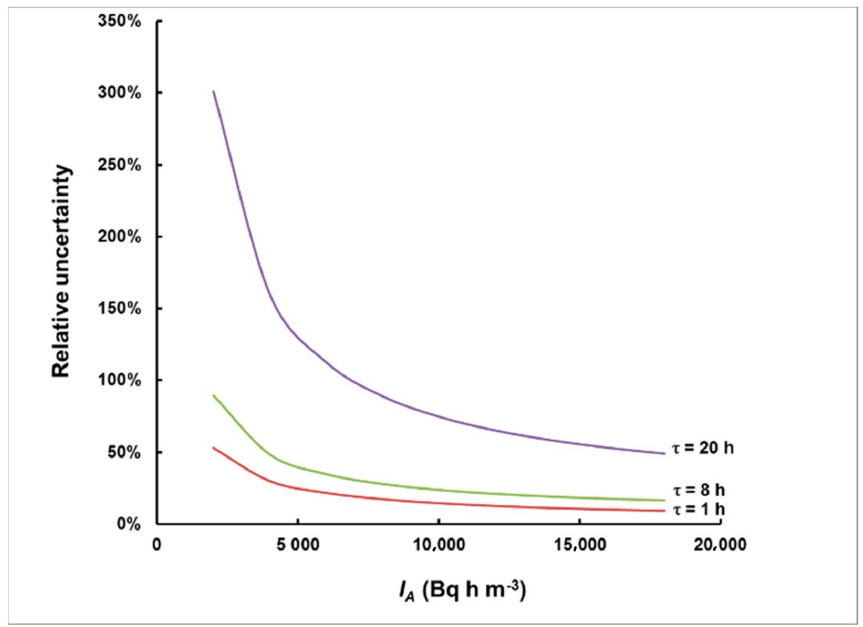
Figure 10. Relative uncertainty in the integrated activity concentration for measurements started with a delay of 1 h, 8 h and 20 h.